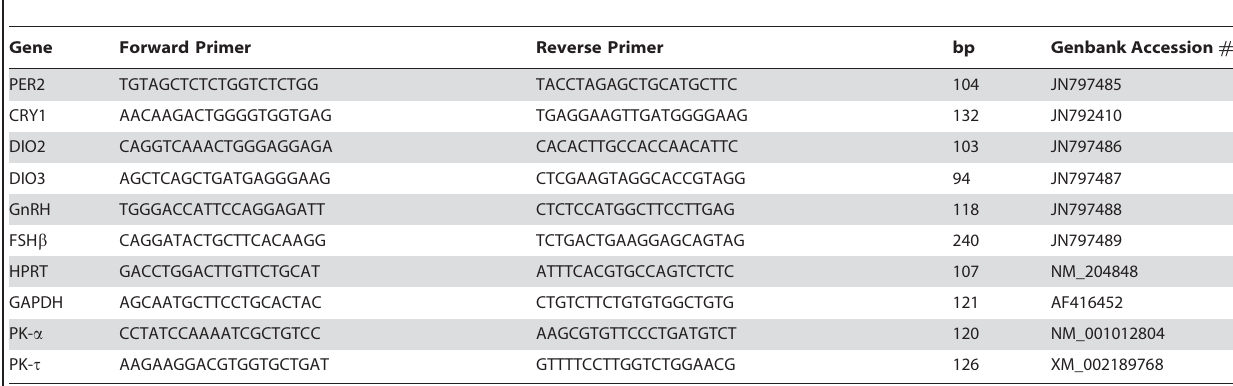
Table 1. Primer sequences and anticipated size of the amplified